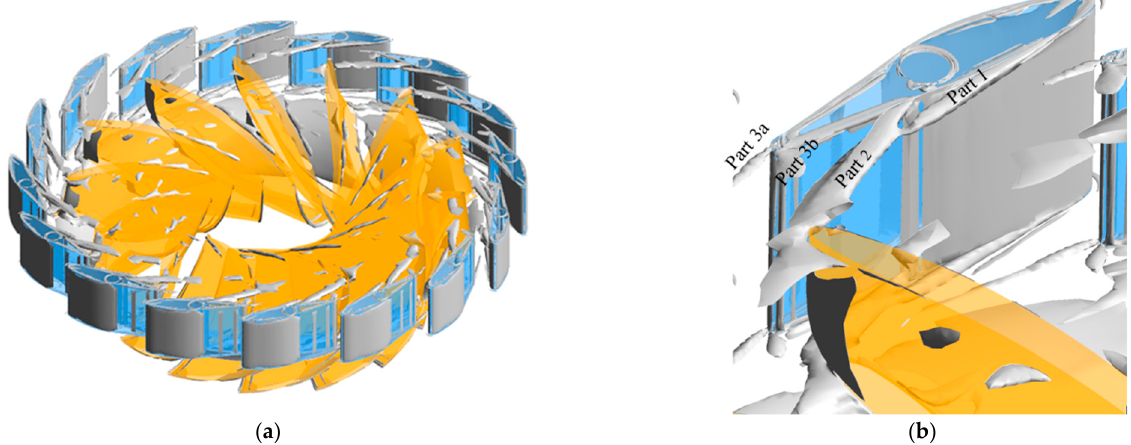
Figure 8. Leakage vortex from the GV: ( a ) Pattern as observed for complete set of GVs and runner blades; ( b ) Single GV and runner blade showing three distinct leakage flow areas.